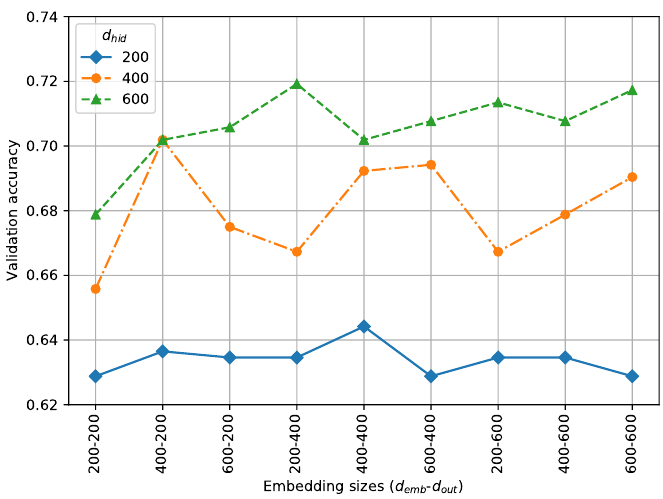
Figure 3. Performance comparison for different numbers of nodes.